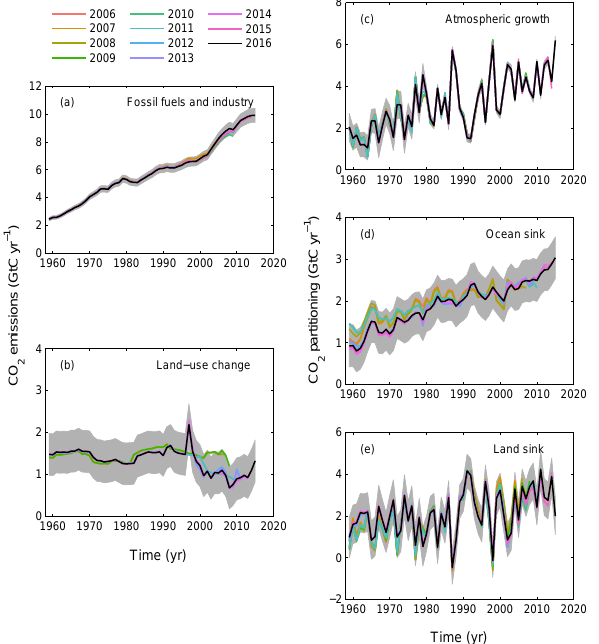
Figure 9. Comparison of global carbon budget components re- leased annually by GCP since 2006. CO 2 emissions from (a) fos- sil fuels and industry ( E FF ) and (b) land-use change ( E LUC ), as well as their partitioning among (c) the atmosphere ( G ATM ), (d) the ocean ( S OCEAN ), and (e) the land ( S LAND ). See legend for the cor- responding years, and Table 3 for references. The budget year cor- responds to the year when the budget was first released. All values are in GtCyr − 1 . Grey shading shows the uncertainty bounds repre- senting ± 1 σ of the current global carbon budget.